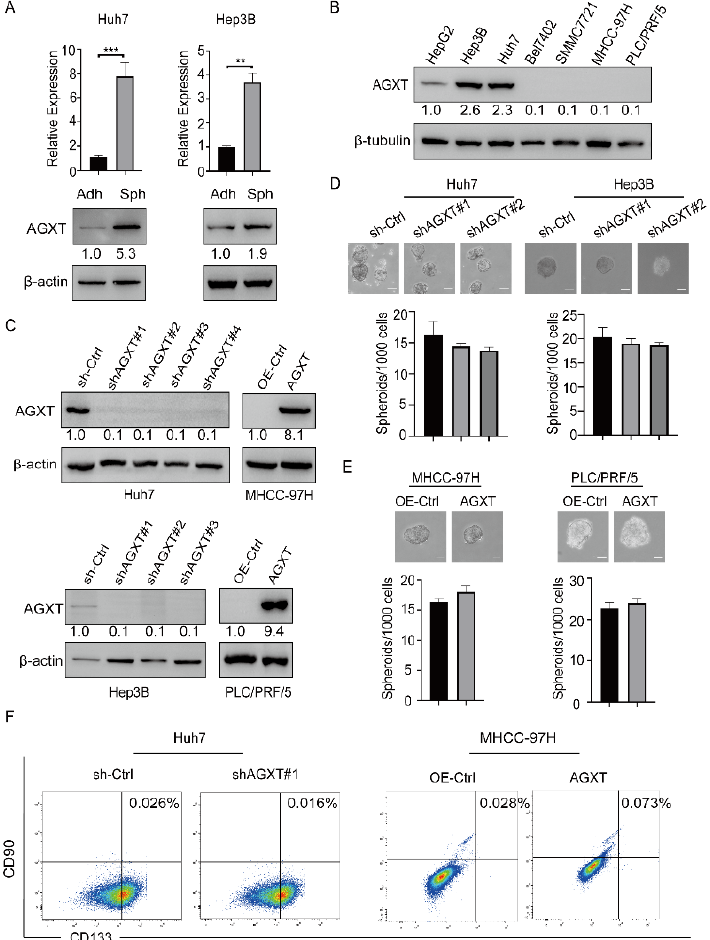
Figure 2. Alanine − glyoxylate aminotransferase (AGXT) expression cannot drive the stemness of hepatocellular carcinoma (HCC) cells: ( A ) Quantitative real − time polymerase chain reaction and Western blot analysis of spheroid cells (Sph) and adherent cells (Adh) among the Huh7 and Hep3B cells; ( B ) Western blot analysis of AGXT in seven HCC cell lines (HepG2, Hep3B, Huh7, Bel7402, SMMC7721, MHCC − 97H, and PLC/PRF/5); ( C ) Western blot exhibited the knockdown of AGXT in the Huh7 cells and Hep3B cells and the exogenous overexpression of AGXT in the MHCC − 97H cells and PLC/PRF/5 cells; ( D , E ) sphere formation assay of stable AGXT knockdown cell lines and AGXT-overexpressing cell lines (top panel). Statistical bar graphs of sphere numbers (down panel). Scale bar, 100 µ m; ( F ) flow cytometric analysis of membrane CD133 + /CD90 + in Huh7 cells and MHCC − 97H cells. ** p < 0.01, *** p < 0.001.